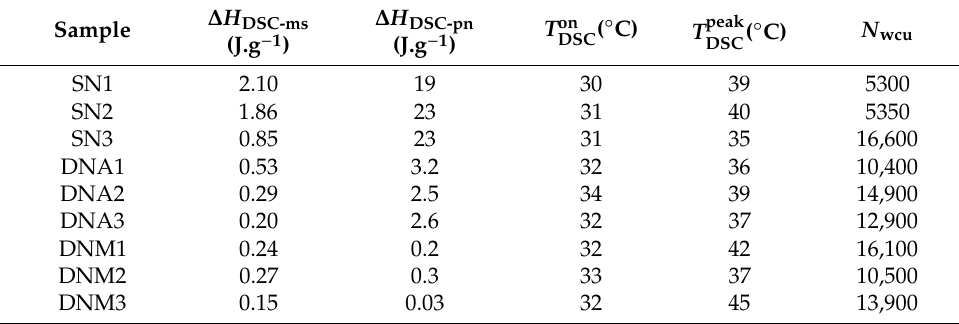
Table 3. Transition characteristics of hydrogels determined during heating by DSC: specific enthalpy of demixing per unit mass of network sample ∆ H DSC-ms , specific enthalpy of demixing per unit mass of polymer network ∆ H DSC-pn , onset temperature of demixing T on number of water molecules in a cooperative water unit N wcu